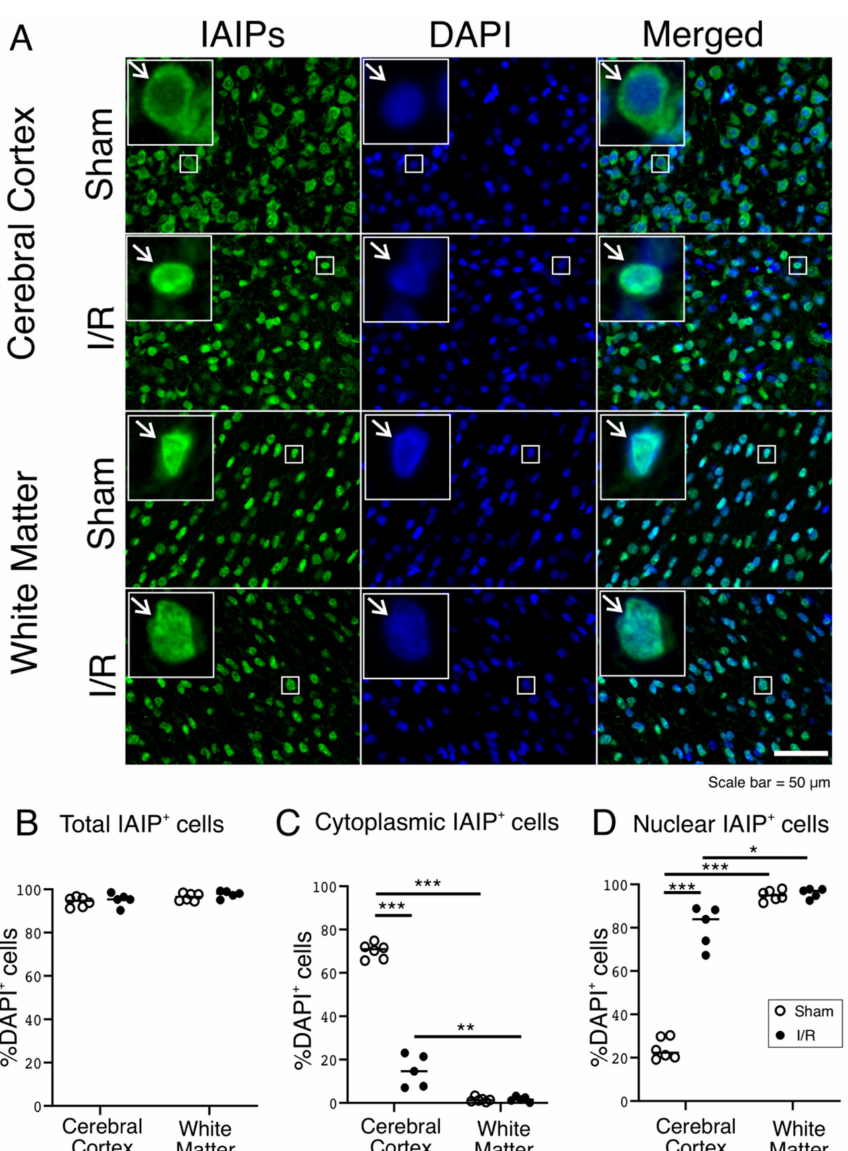
Figure 2. ( A ) Representative images of IAIPs (Green), DAPI-positive cells (Blue) and merged im- munostaining in the cerebral cortex and white matter of fetal sheep in Sham and I/R groups. Magnification, 40 × . Each inset contains high magnification images. Scale bar = 50 µ m. Arrows indicate the same cell. ( B – D ) Quantification of IAIP-positive cells. IAIP-positive cells plotted as a percentage of DAPI-positive cells on the y -axis for total ( B ), cytoplasmic, ( C ) and nuclear ( D ) compartments in the cerebral cortex, and white matter plotted on the x -axis for the Sham (open circles) and I/R (closed circles) groups. Values median and scattergrams. * p < 0.05, ** p < 0.01, *** p < 0.001